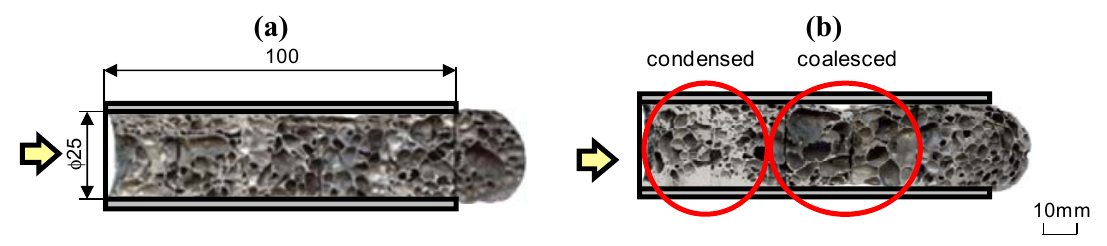
Figure 2. Cross-sectional shape of Al foam molded into pipe: ( a ) Cooling with blowing air